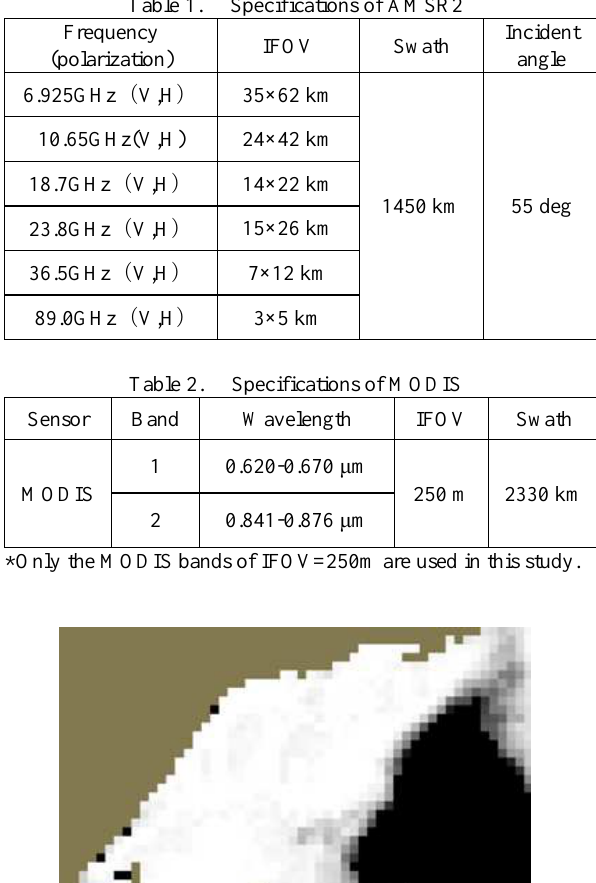
Figure 3. The schematic diagram of calculating ice concentration(IC) from brightness temperature (TB) derived from passive microwave